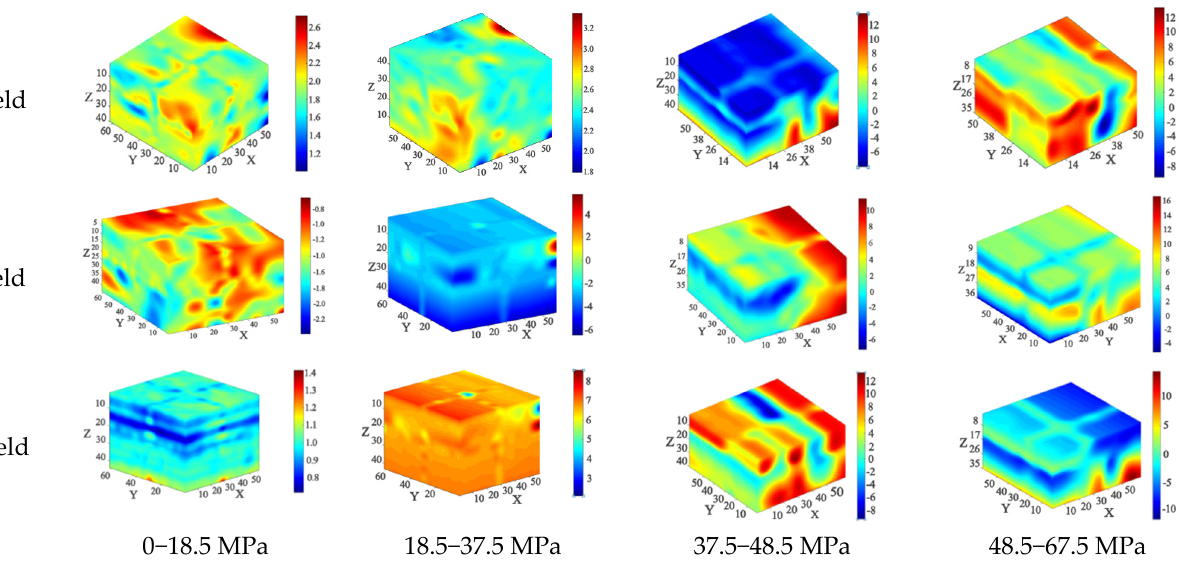
Figure 15. Evolution process of displacement field u, v, and w in x, y, and z directions.